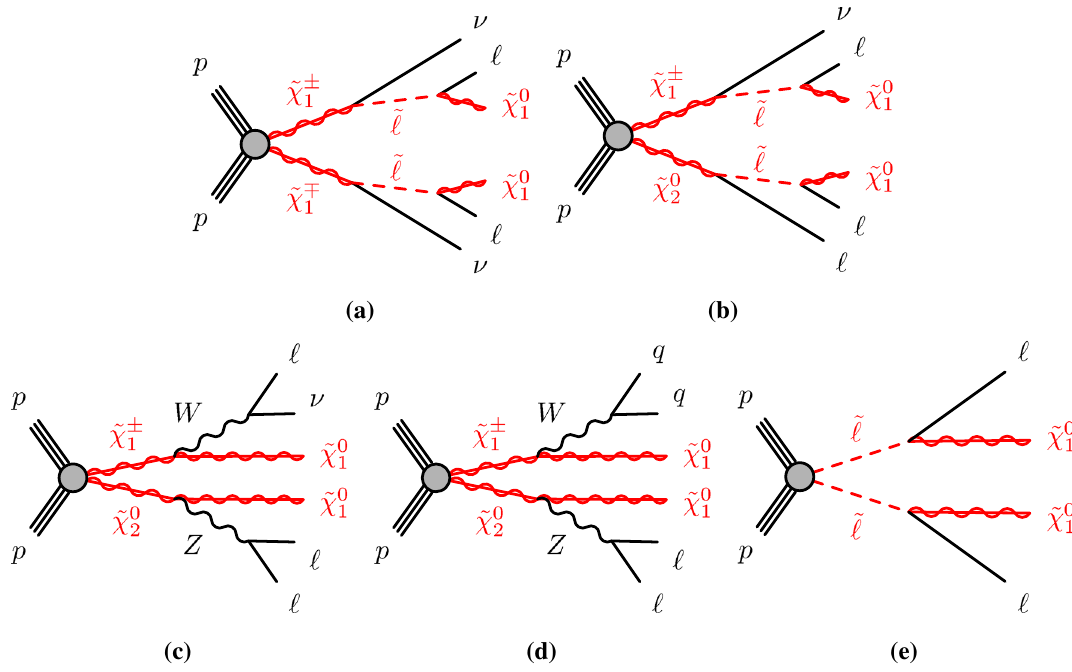
+ ˜ χ − and Z bosons into final states with three leptons, d ˜ χ 1 1 with decays via a hadronically decaying W boson and a leptonically decaying Z boson into final states with two leptons and two jets, and